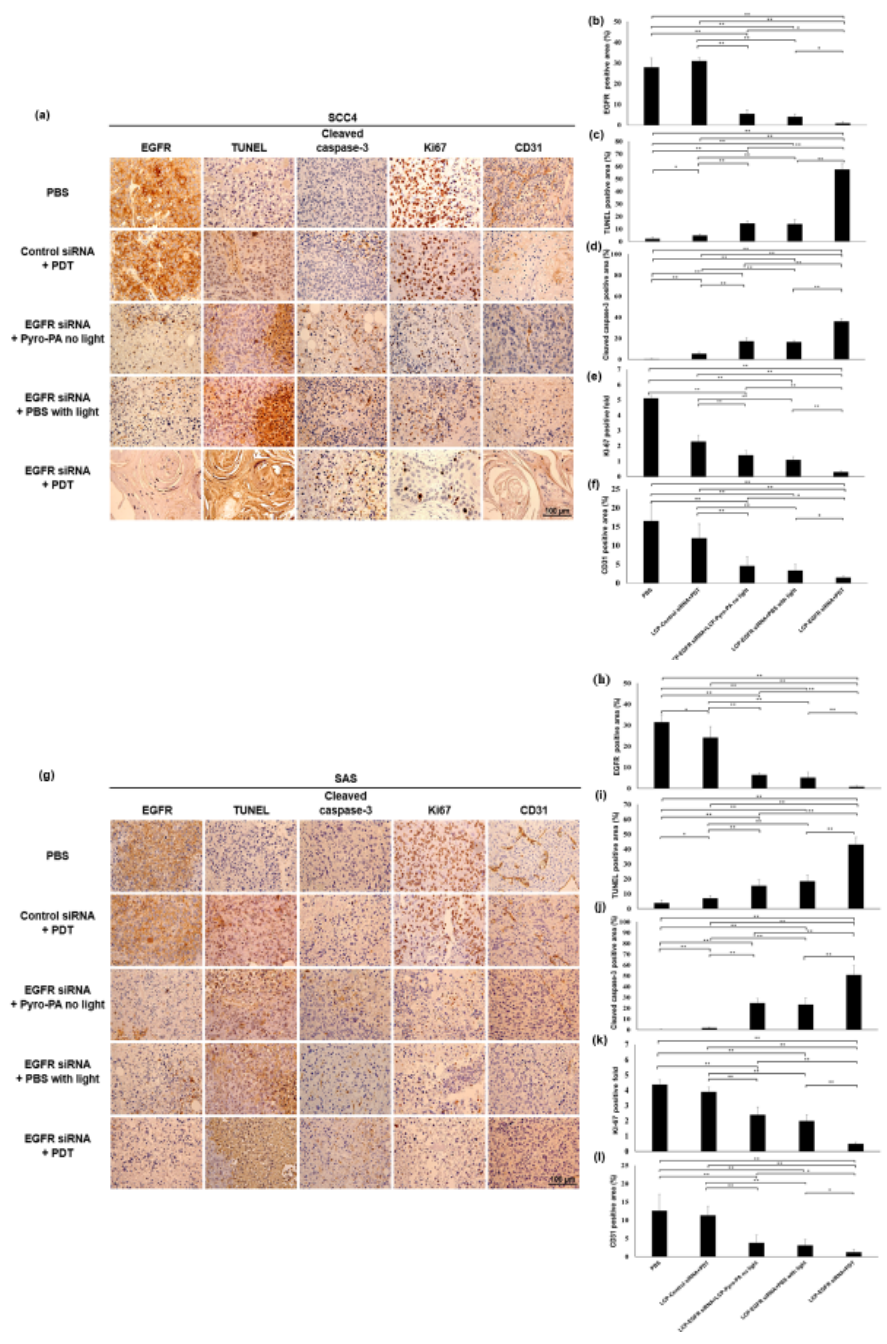
Figure 7. Immunohistochemistry of SCC4 and SAS Tumors; SCC4 tumor cell proliferation and apoptotic cells. Phosphoylated-EGFR ( a ), TUNEL, cleaved caspase-3, Ki-67 and CD31 assays for SCC4 tumor tissue sections. Original magnification x40. Scale bar stands for 100µm. Quantitative analysis for Phosphoylated-EGFR (1092) ( b ), TUNEL ( c ), Cleaved Caspase-3 ( d ), Ki-67 ( e ) and CD31 ( f ). SCC4 tumor cell proliferation and apoptotic cells. Phosphoylated-EGFR ( g ), TUNEL, cleaved caspase-3, Ki-67 and CD31 assays for SAS tumor tissue sections. Original magnification x40. Scale bar stands for 100 µm. Quantitative analysis for phosphoylated-EGFR (1092) ( h ), TUNEL ( i ), cleaved caspase-3 ( j ), Ki-67 ( k ) and CD31 ( l ). Columns, mean (7 images); * p < 0.05; ** p < 0.01.